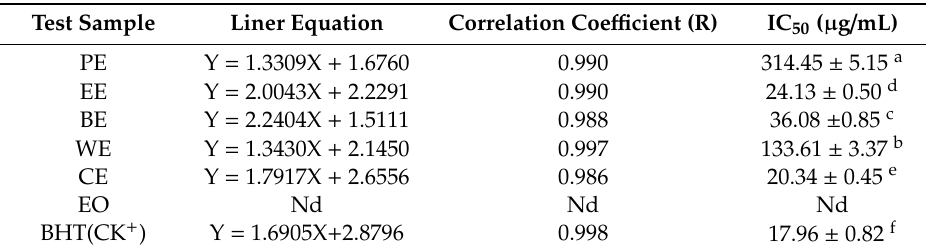
Table 5. DPPH radical scavenging activity of Rhodiola